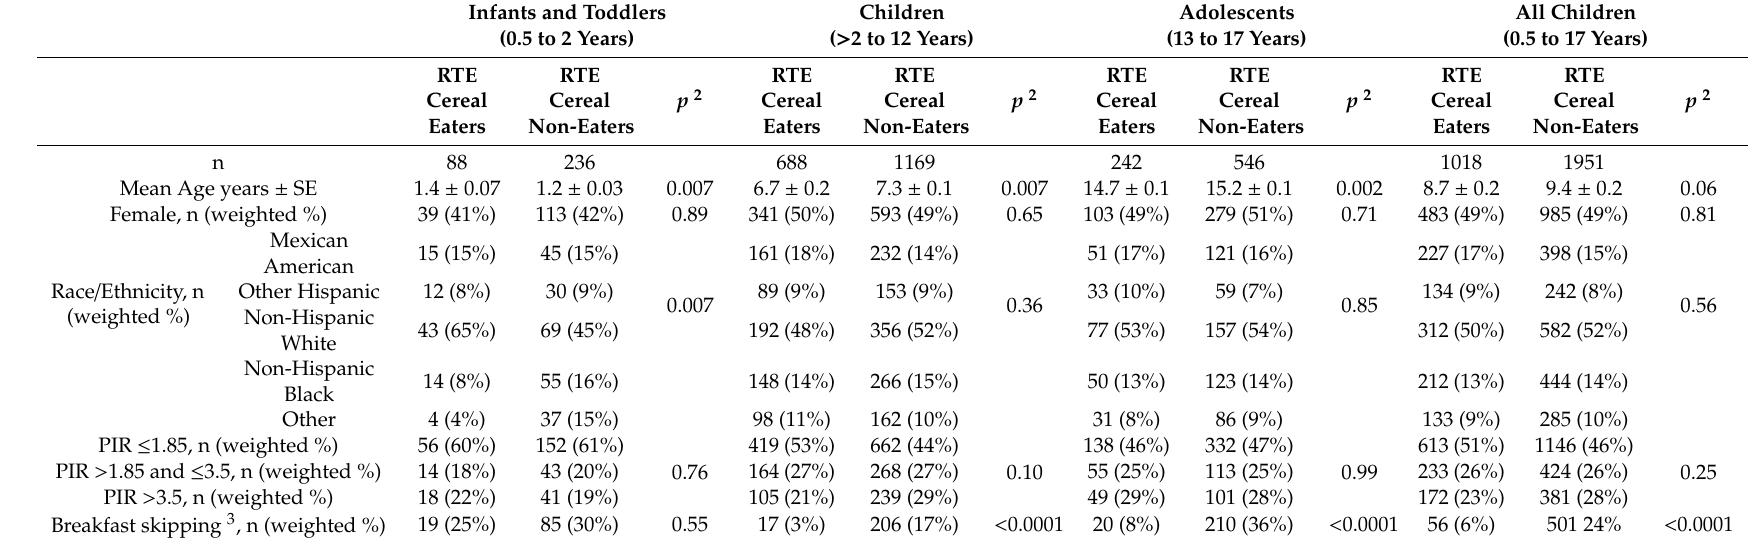
Table 1. Demographic characteristics of ready-to-eat cereal (RTEC) eaters and non-eaters among children using data from the National Health and